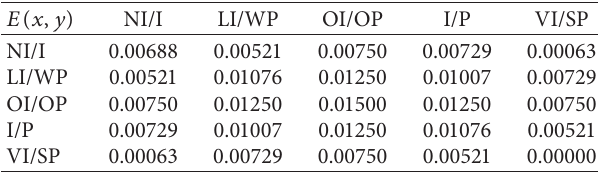
Table 2: Errors of